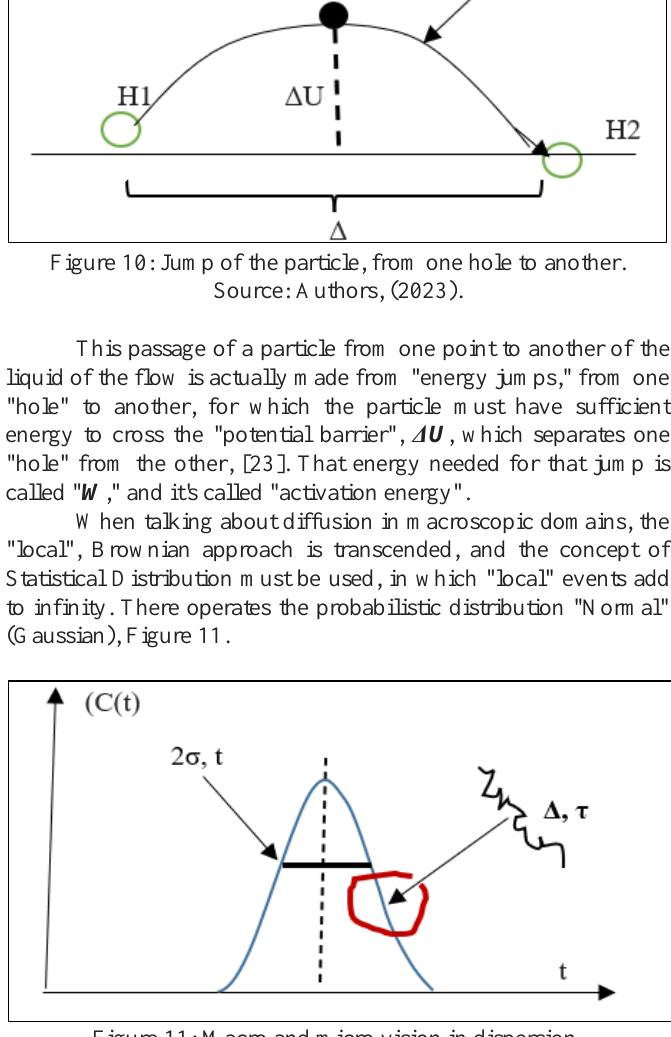
Figure 11: Macro and micro vision in